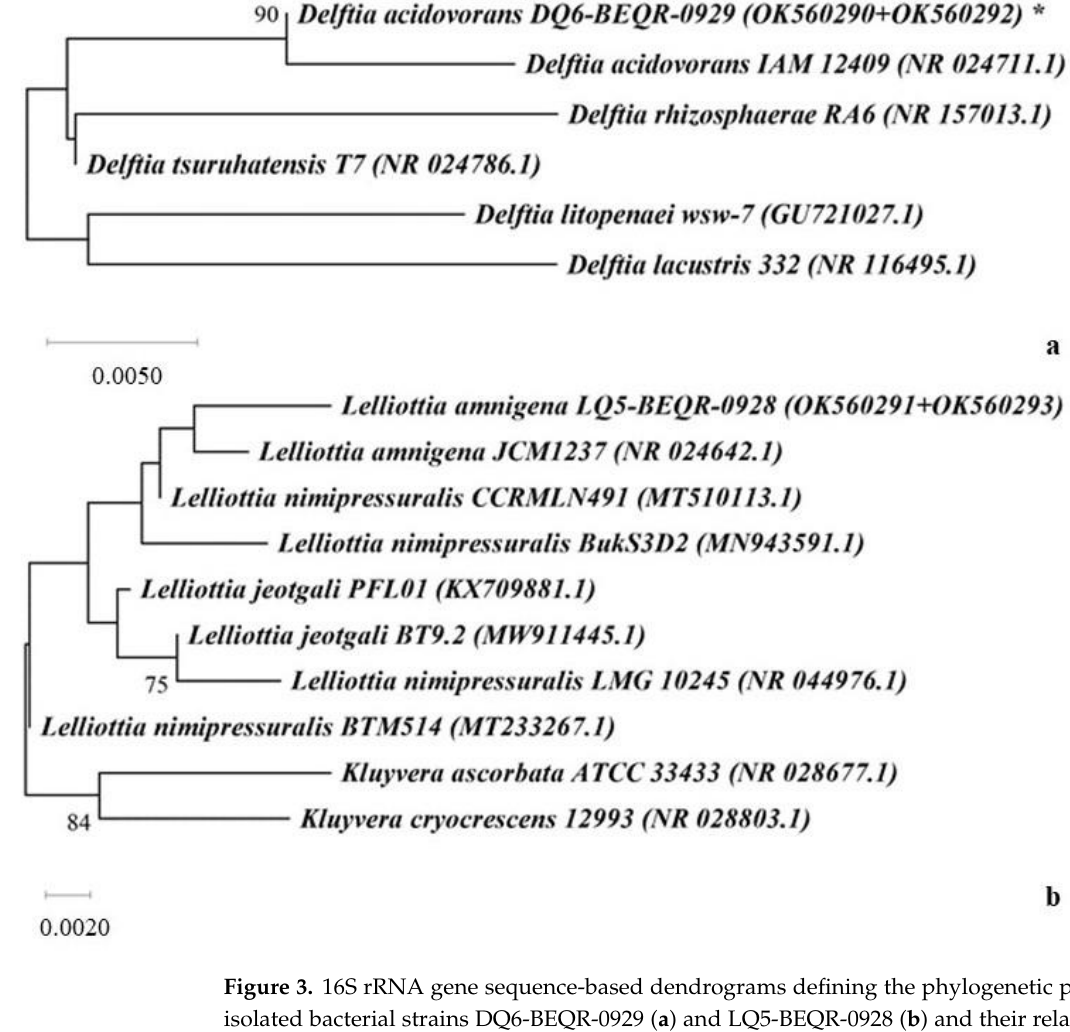
Figure 3. 16S rRNA gene sequence-based dendrograms defining the phylogenetic position of the isolated bacterial strains DQ6-BEQR-0929 ( a ) and LQ5-BEQR-0928 ( b ) and their relationship with other close relative microorganisms. The isolated strains are indicated *.